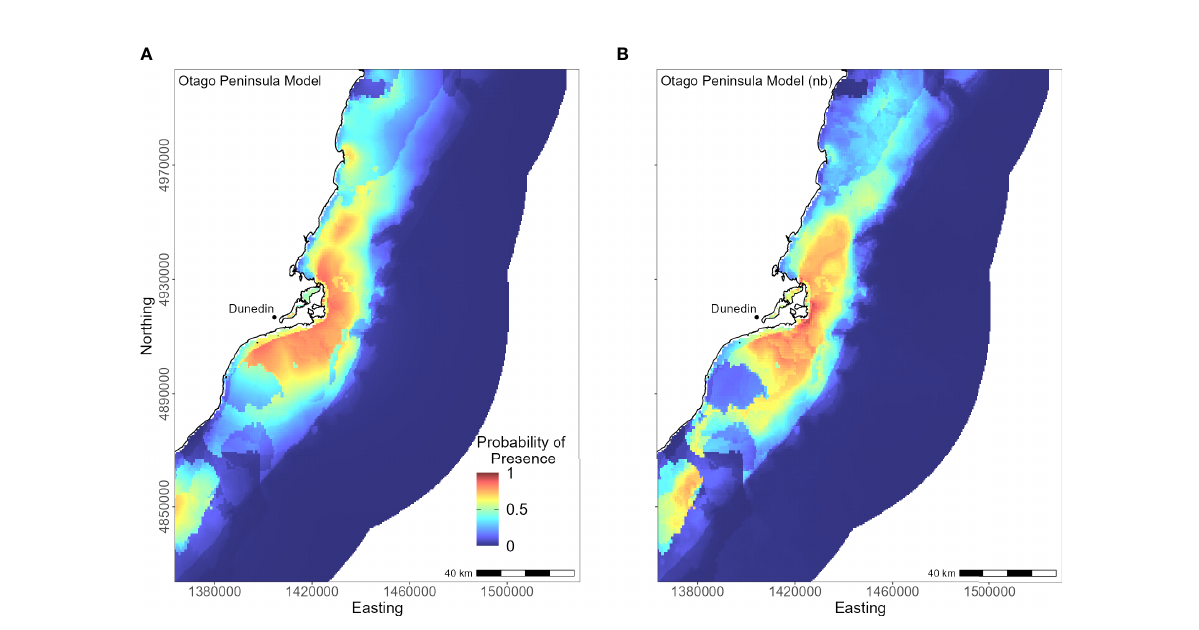
FIGURE 8 Distribution of suitable habitat for yellow-eyed penguins breeding on Otago Peninsula. The left map (A) depicts the predicted probability of presence (cloglog) with distance to nearest colony included a predictor variable, while the right map (B) does not include distance to colony as a predictor (nb